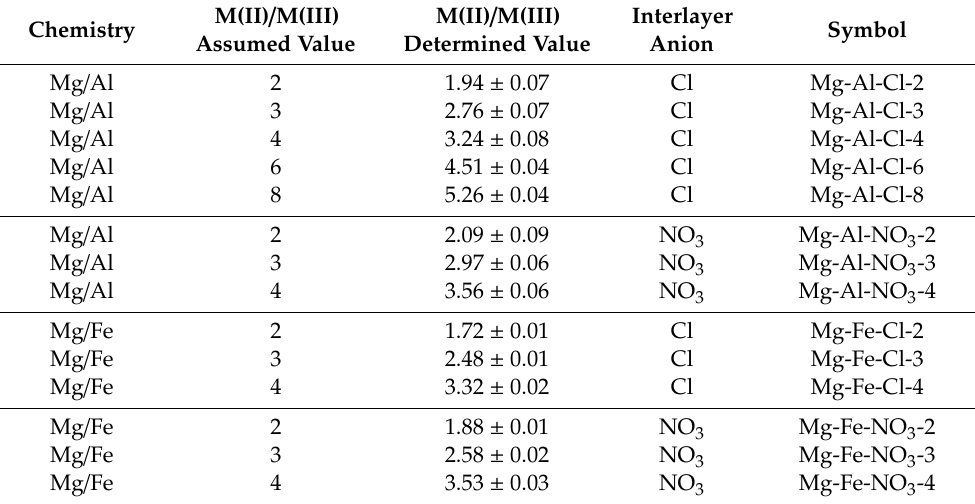
Table 1. The layered double hydroxide (LDH) materials used in the study with the chemistry of the brucite-like